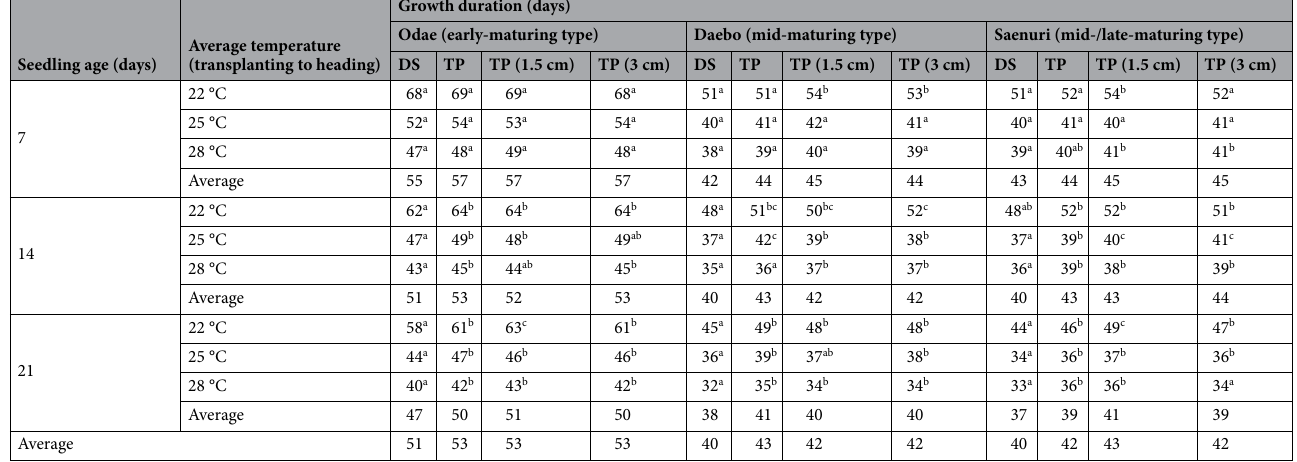
Table 1. Growth duration of rice from transplanting to heading in relation to root damage during transplanting, seedling age, and growth temperature. DS direct seeding, TP transplanting (no root damage), TP (1.5 cm) roots cut to 1.5 cm, TP (3 cm) roots cut to 3 cm. Significant differences were evaluated using Duncan’s multiple range test at the 5% level. Within each column, values followed by different letters (a to c) are significantly different (P <